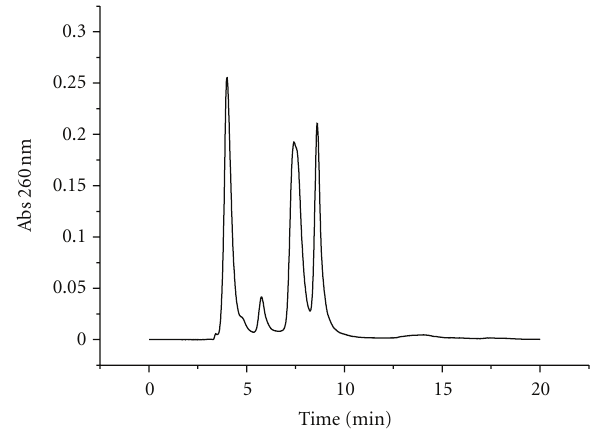
Figure 4: HPLC profile of DMT-containing oligonucleotide 2 with two arms. Truncated sequences without DMT groups had a retention of less than 5 min. Fraction eluting between 7-8min contained oligonucleotides with a single DMT group. The last fraction contained the desired sequence with two DMT